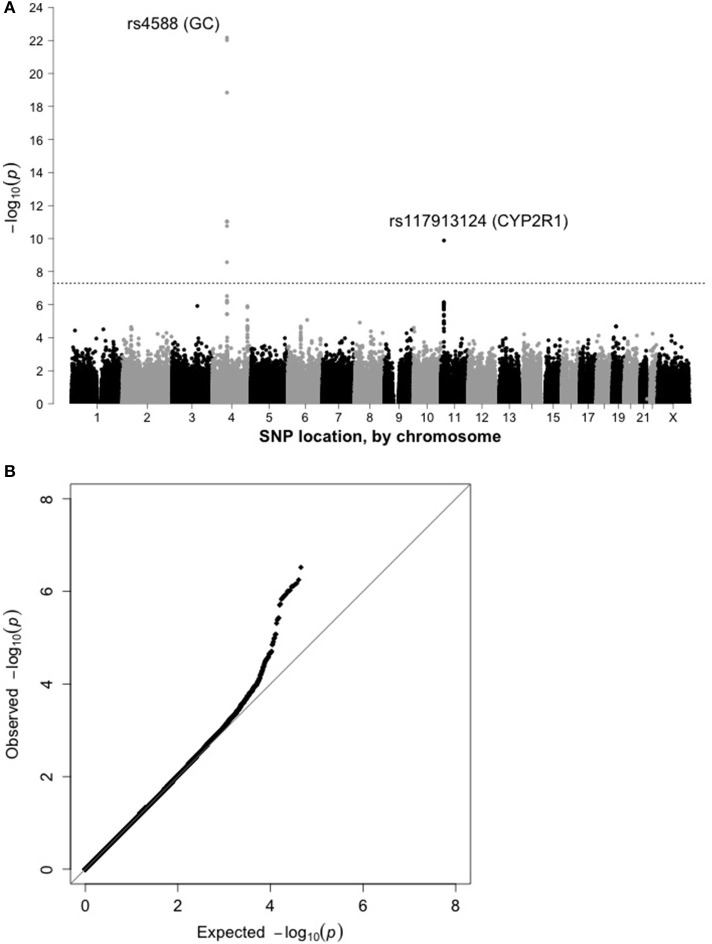
(A) Manhattan plot for 25(OH)D in the sub-cohort (n = 1,829). (B) Quantile-quantile plot for 25(OH)D in the sub-cohort (n = 1,829).